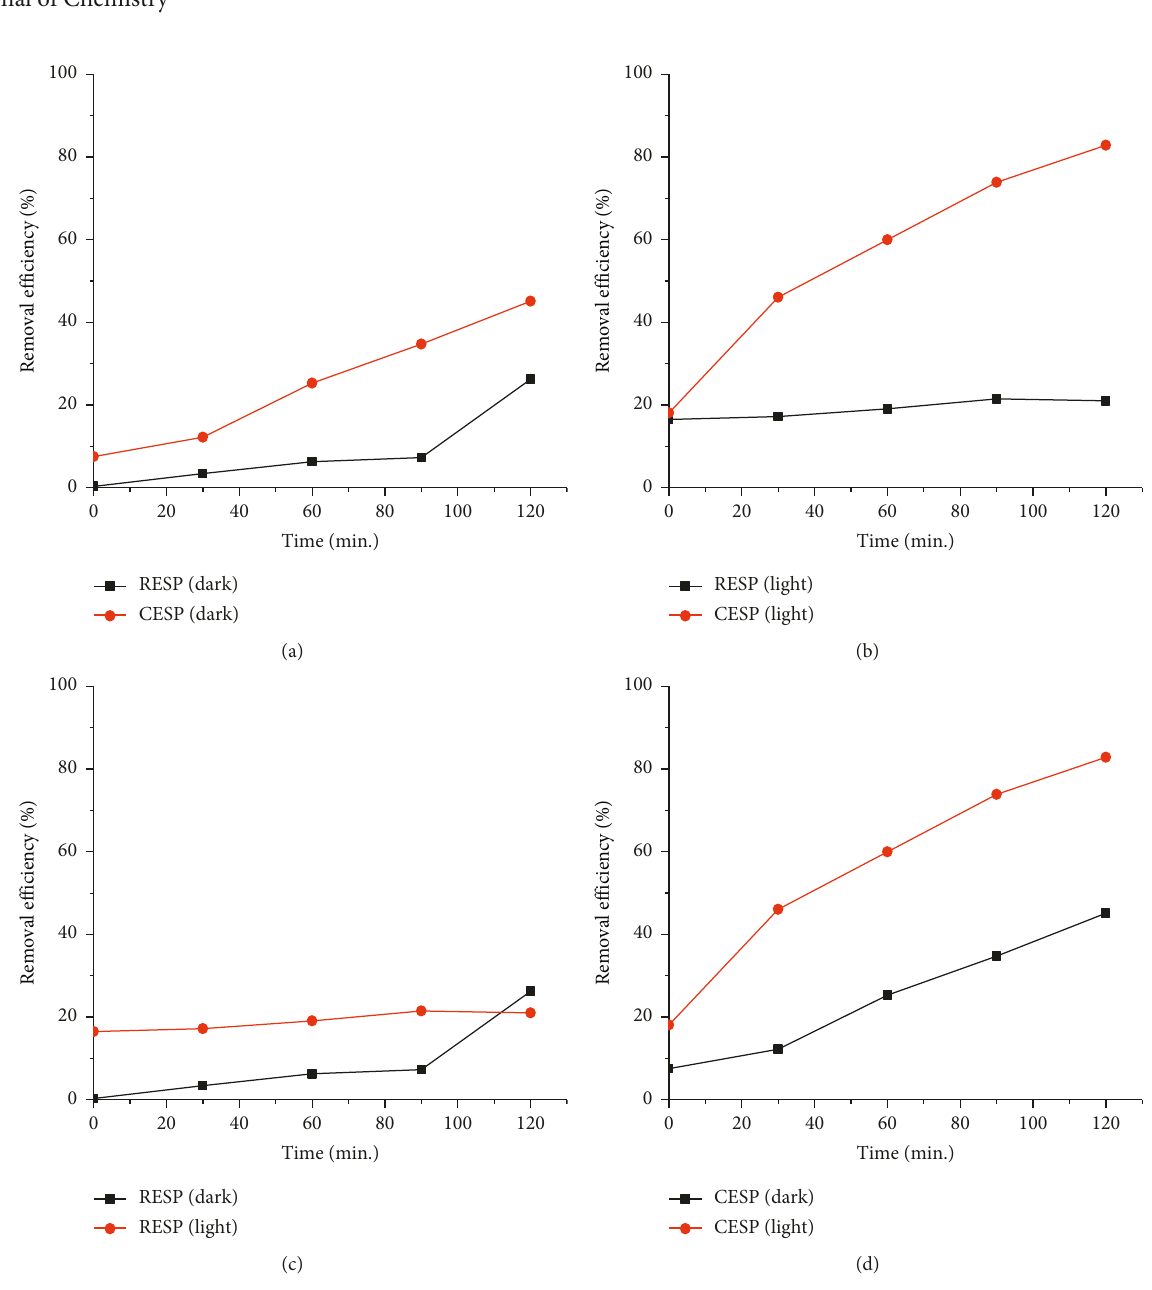
Figure 6: Removal efficiencies of MB in raw egg shell powder and calcined egg shell